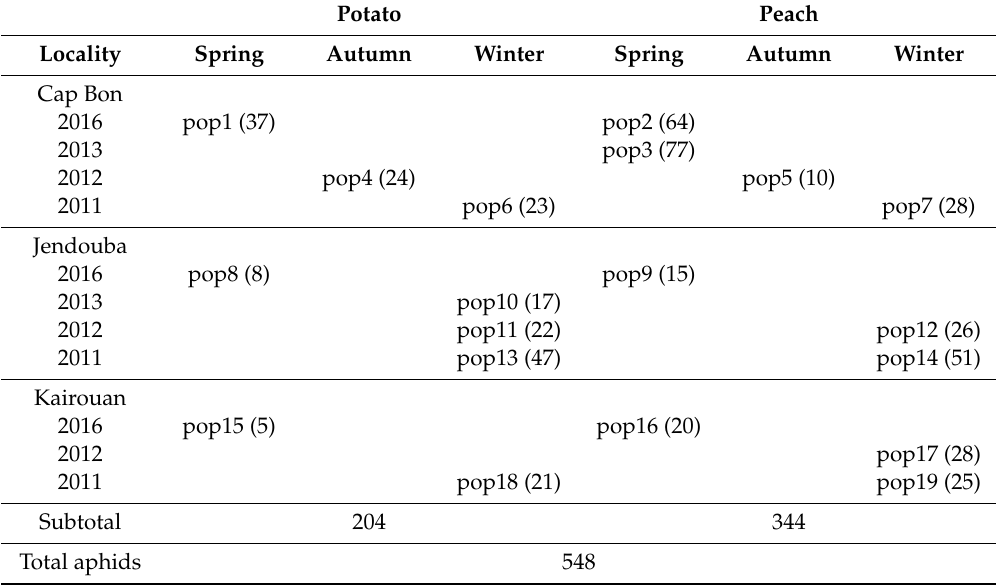
Table 1. Number of M. persicae collected on peach orchards and potato seed crops in three localities in Tunisia during 4 years of monitoring. Samples were grouped on 19 populations according to the host, season, locality and year of collection. The number of individuals examined is shown in parentheses. Potato Peach Locality Spring Autumn Winter Spring Autumn